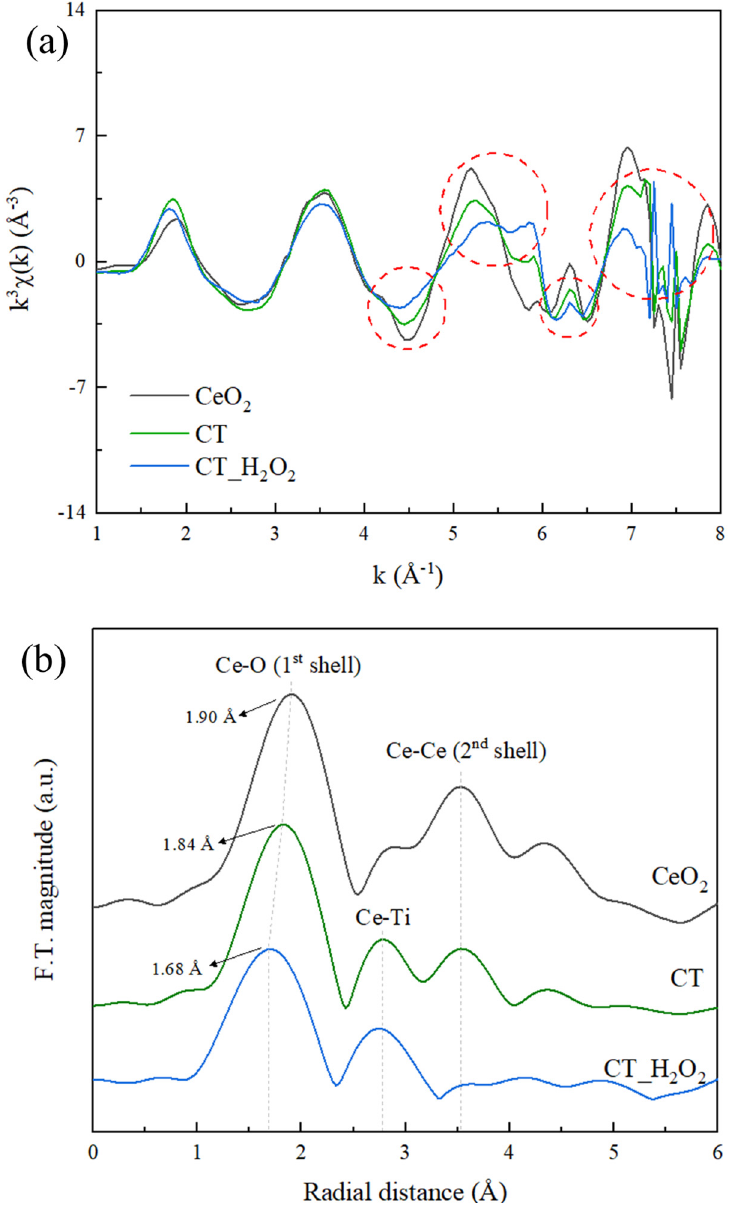
Figure 4. ( a ) Extended X-ray absorption fine structure (EXAFS) k 3 χ data and ( b ) Fourier transform of the EXAFS k 3 χ data at the Ce L 3 -edge EXAFS of CT and CT_H 2 O 2 .